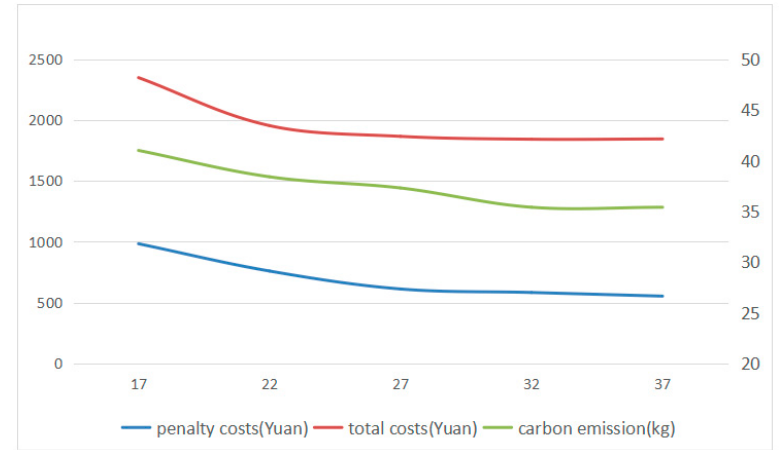
Figure 6. The change of penalty costs, total costs, and carbon emission under different battery capacity.